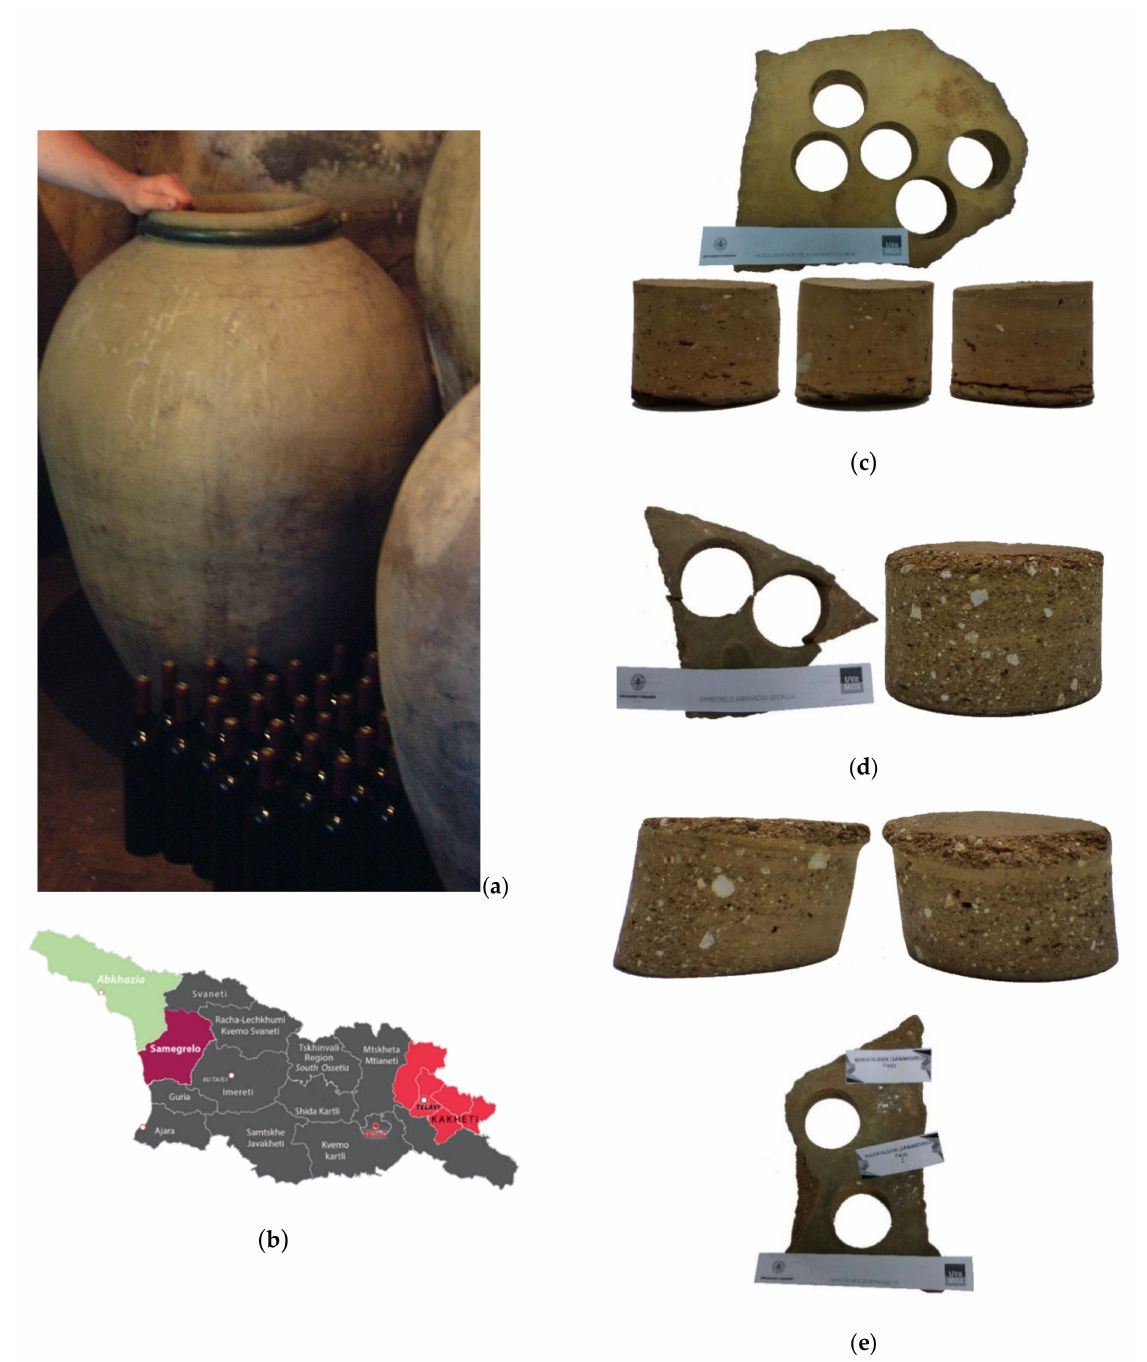
Figure 4. ( a ) Actual Qvevri vessels; ( b ) regions of origin of the ceramics tested, Georgia. Vessel pieces and specimens extracted for testing ( c ) Vardisubani near Telavi (Kaheti); ( d ) Abhkazia (Makatubani), and ( e )